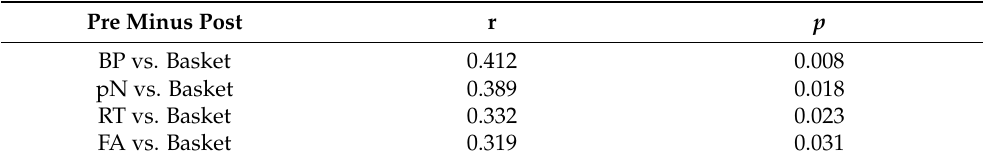
with global basketball performance